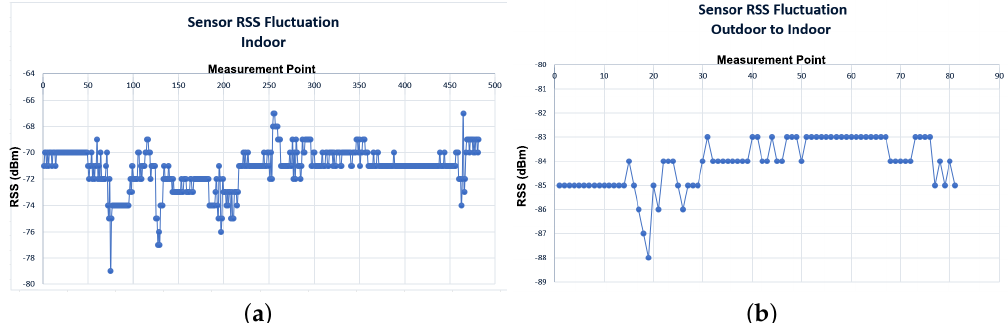
Figure 9. Measured RSS fluctuation of sensors ( a ) Indoor; ( b ) Outdoor.